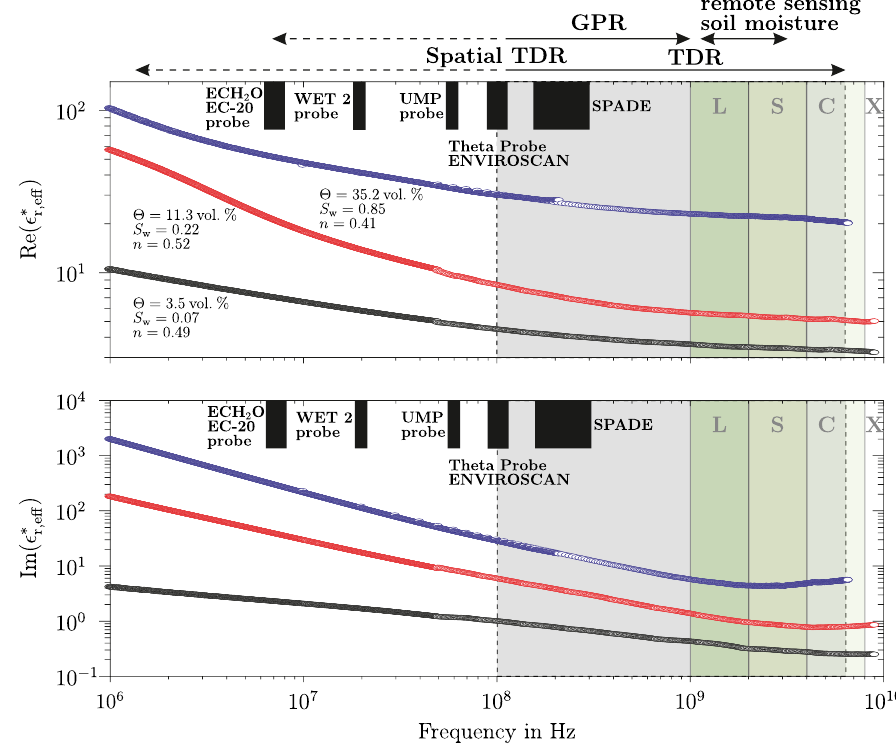
Figure 1. Complex relative effective permittivity (cid:101) ∗ of a silty clay loam with different volumetric r,eff water contents θ or water saturations S w and porosities n (figure according to [25]). L, S, C and X are the names of frequency bands and the black blocks depict the narrow frequency ranges of typical soil moisture